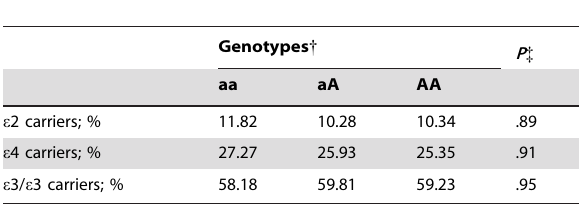
Table 3. ApoE genotypes by LRP-1 I10701 genotype.